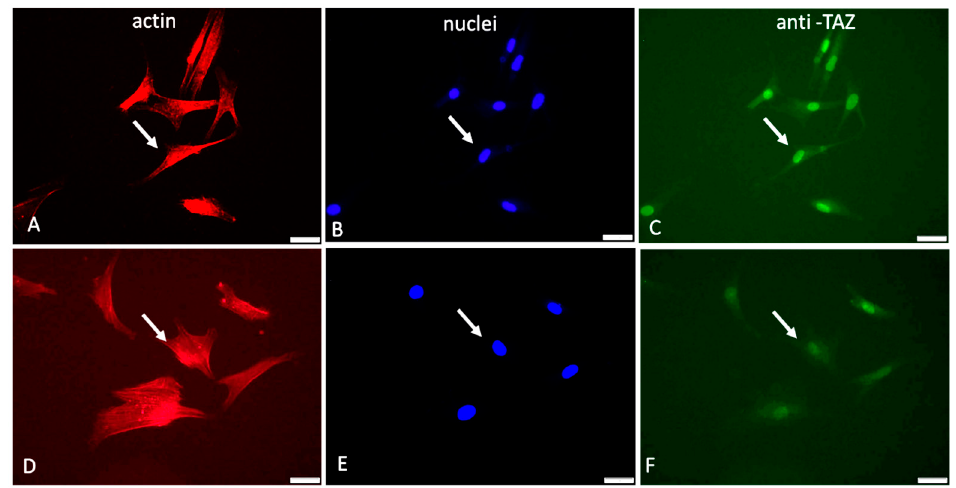
Figure 3. Immunofluorescent visualization of YAP/TAZ activity in ADMSCs adhering to native ( A – C ) and oxidized collagen samples ( D – F ). The same field was viewed at different channels of the microscope: red (actin cytoskeleton), blue (nucleus), and green (for TAZ activity). Arrows on all the images show the location of the nucleus. Bar 20 µ m.